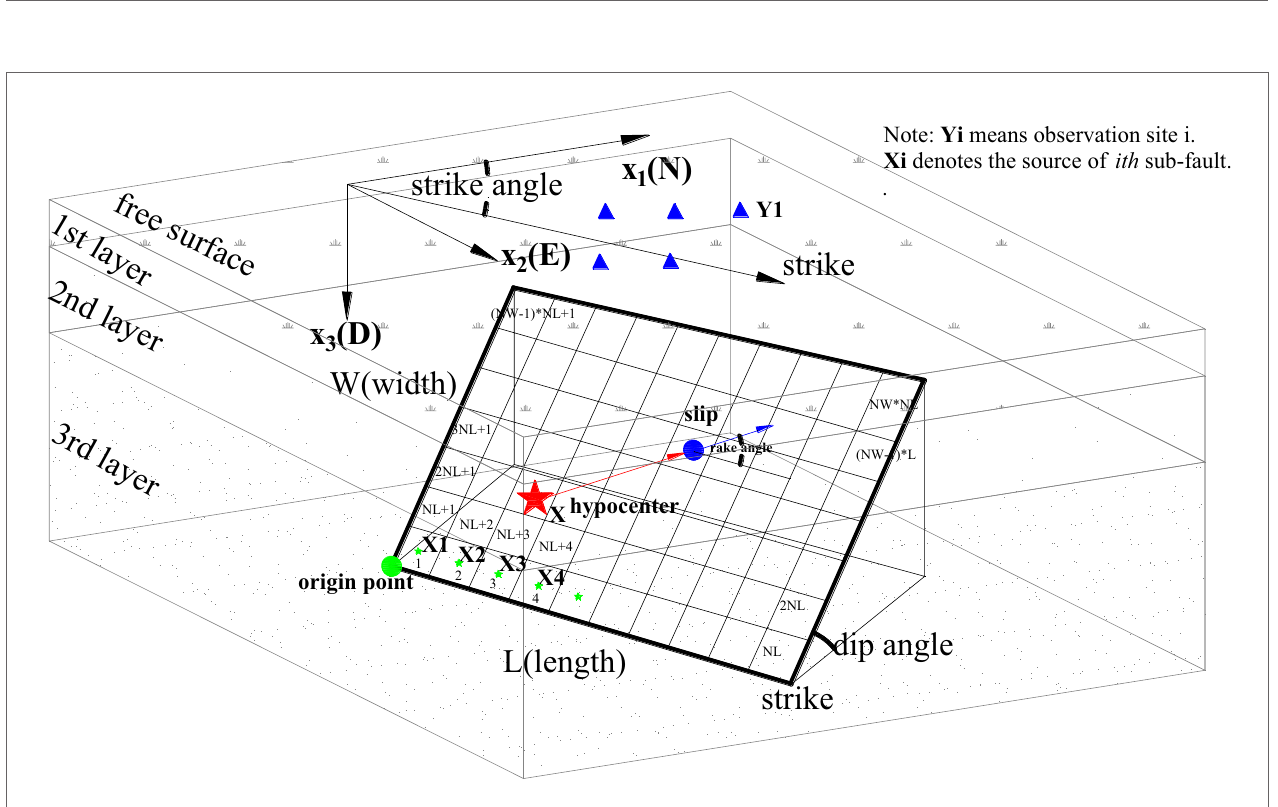
FigUre 4 | step-like displacement time histories of near-fault significant earthquake records (a) fault veridical component (B) fault normal component .